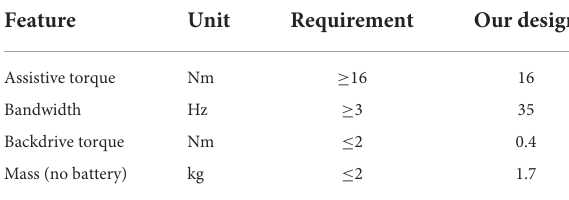
TABLE 1 Design requirements for the knee exoskeleton.